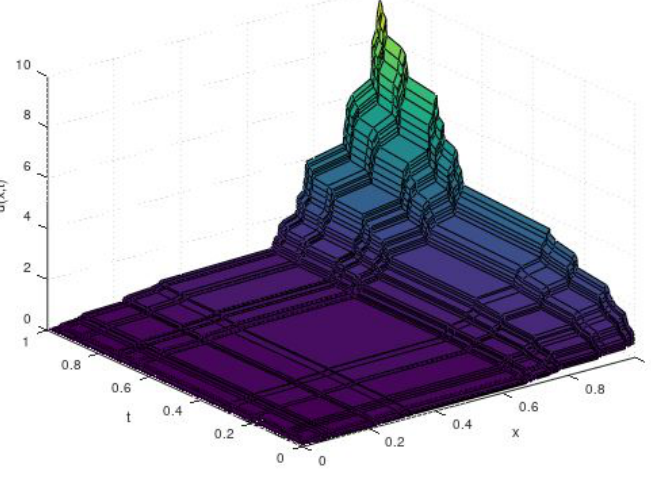
Figure 5. Outcome of Example 2 for α = 0.632 at n = 2.